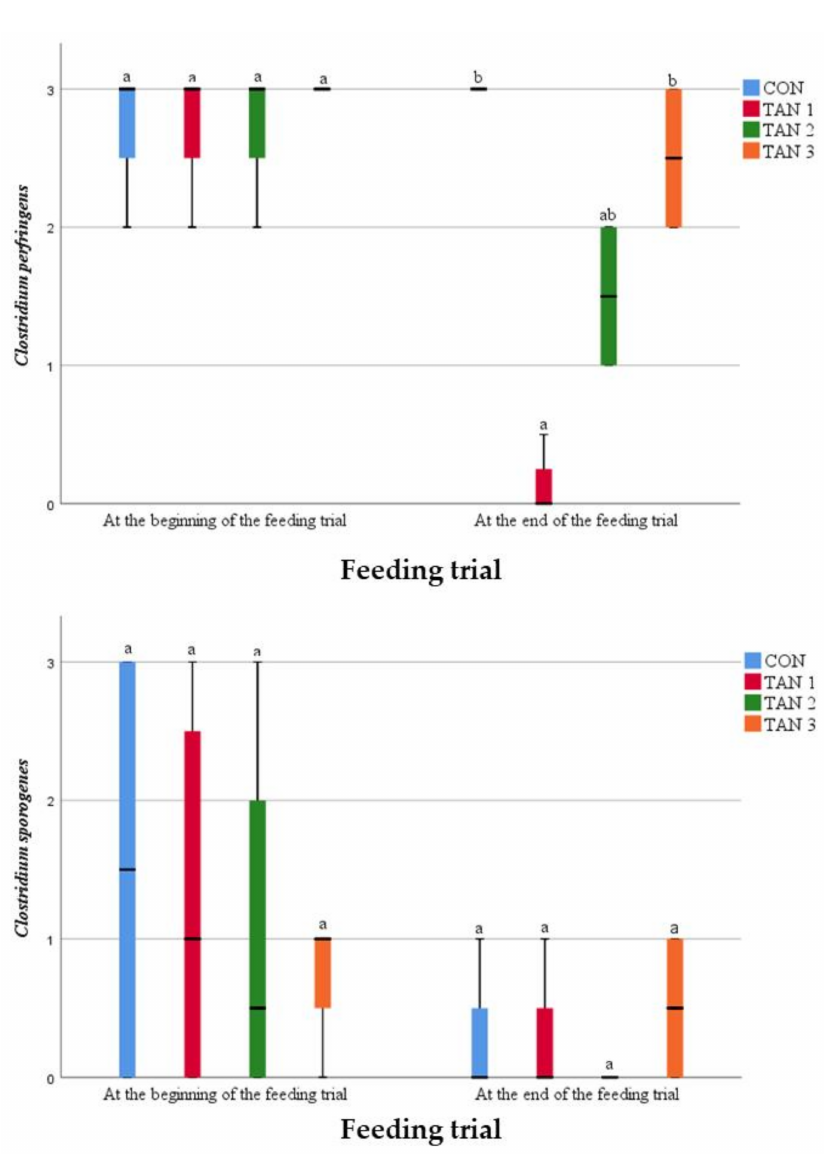
Figure 2. Concentration of selected Clostridia in 1 g of fecal samples before and after tannin sup- plementation. No tannin additive in the diet (CON); 10 g of mixture (HT + soy protein additive) per animal—1.0 g kg − 1 DM (TAN 1); 15 g of HT additive per animal—1.5 g kg − 1 DM (TAN 2); and 15 g of HT additive per animal added to the TMR diet with reduced quantity of concentrate in nominal value—1.5 g kg − 1 DM (TAN 3). Number 0 = no growth; number 1 = 1–10 colonies; number 2 = 11–50 colonies; number 3 => 50 colonies; a, b different superscript letters indicate differences (Dunn–Bonferroni post hoc test; p < 0.05) between